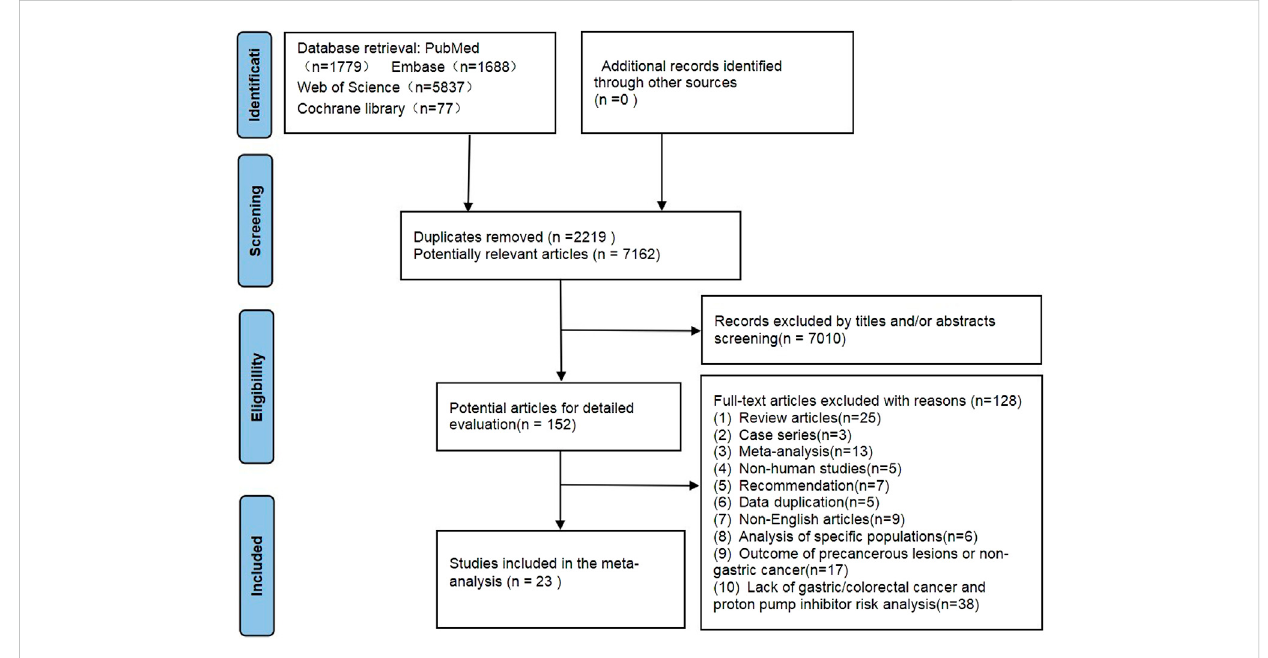
FIGURE 1 Flow chart of study selection